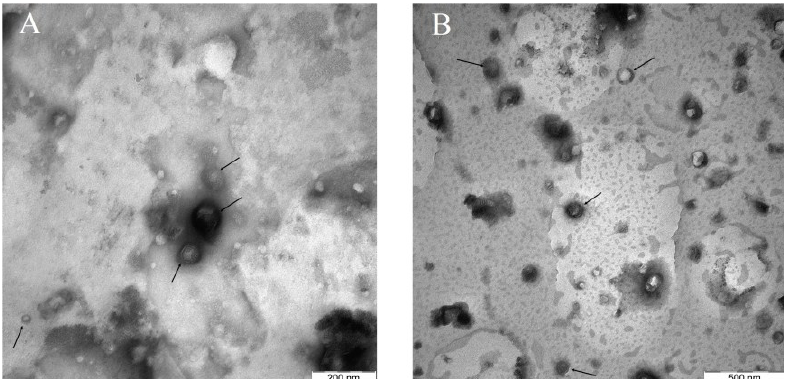
Figure 7. TEM micrograph of 40 Mm linolenate-linolenic acid vesicle (A) and PEGylated linolenate-linolenic acid vesicle (B) at pH 8.5. The presences of vesicles are indicated by the